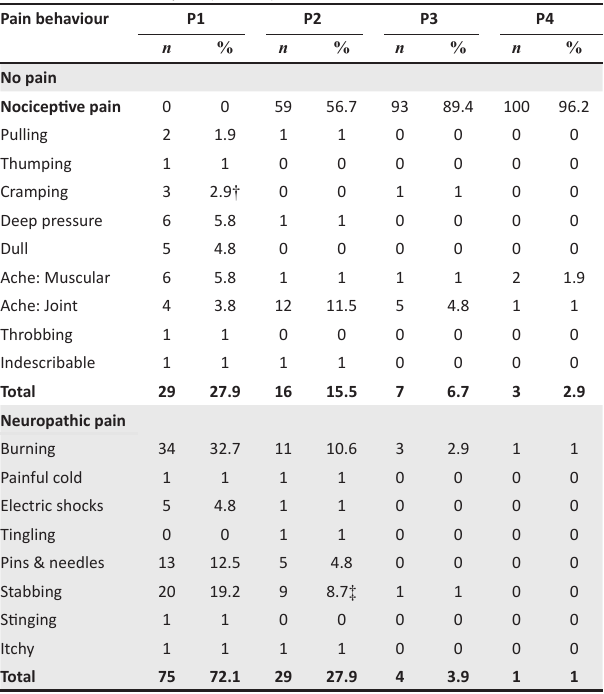
TABLE 3: Behaviour of pain ( n =